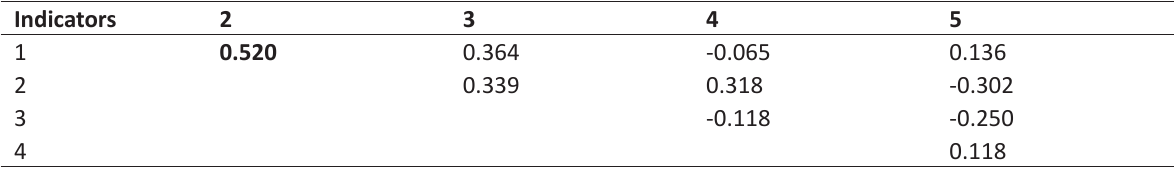
Table 6. Correlations between self assessment and aggression’s kinds in Judo wrestlers- youngsters (r)